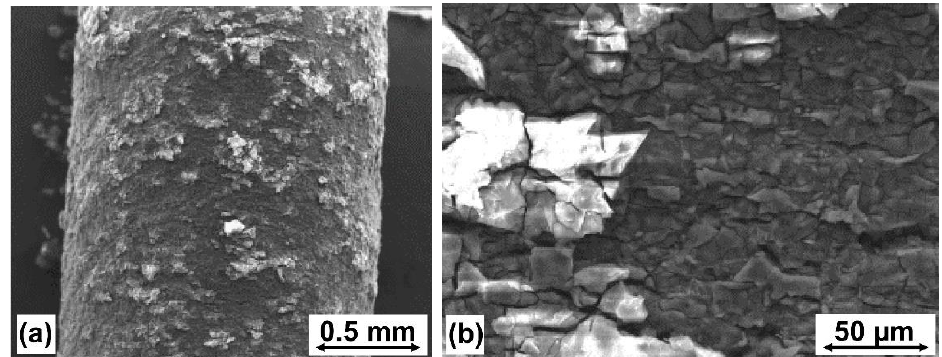
Figure 7. Typical images of the wire surface after 7 days of corrosion before cleaning (MgCa0.7 wire after extrusion, registered by scanning electron microscope). Wire surface in scale: ( a ) 0.5 mm; ( b ) 50 µm.